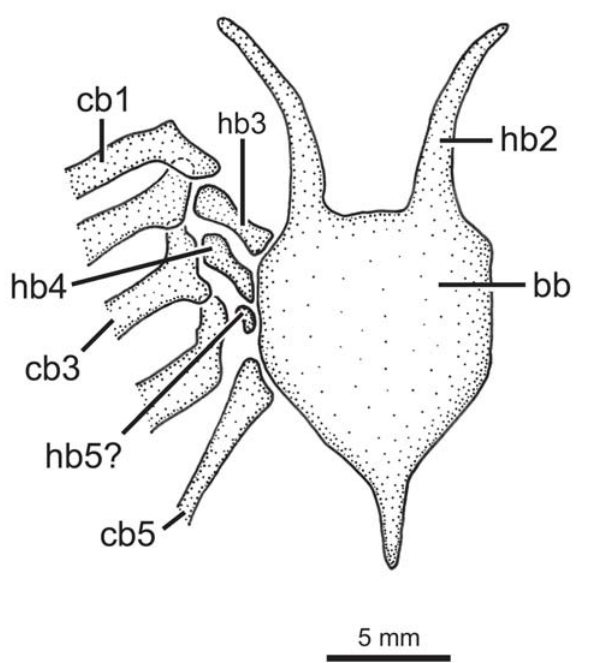
Fig. 11. Dorsal view of left ventral gill arches of Malacoraja obscura , n. sp. Basihyal, hypobranchial 1, and ventral pseudohyoid omitted. Abbreviations: bb , basibranchial plate; cb 1-5 , ceratobranchials 1-5; hb 2-5 , hypobranchials 2-5. An- terior toward